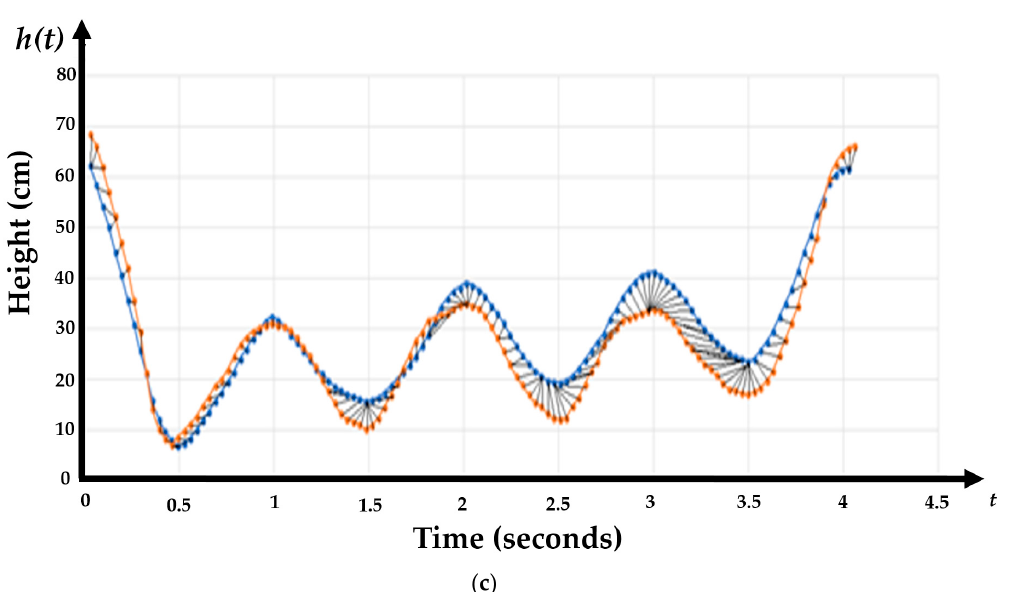
Figure 10. Visual representation of dynamic time warping (DTW) with the optimal warp, where the blue line represents the template and the orange line represents the users’ gesture: ( a ) duple gesture, ( b ) triple gesture, and ( c ) quad gesture.